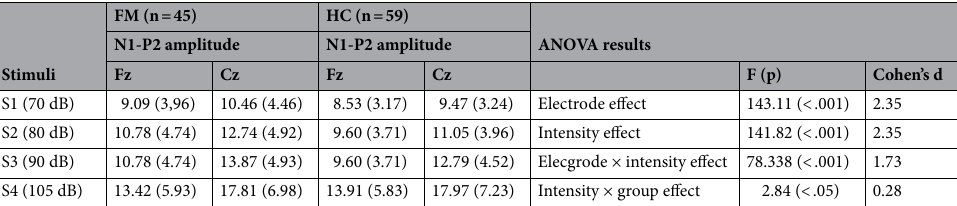
Table 2. Left: N1-P2 peak-to-peak amplitudes (in µV) measured at the Fz and Cz electrodes to the different intensities (S1, S2, S3 and S4) (standard deviations in parentheses), for patients with Fibromyalgia (FM) and healthy controls (HC). Right: Repeated measures ANOVA analysis significant results and effect sizes (Cohen’s d).